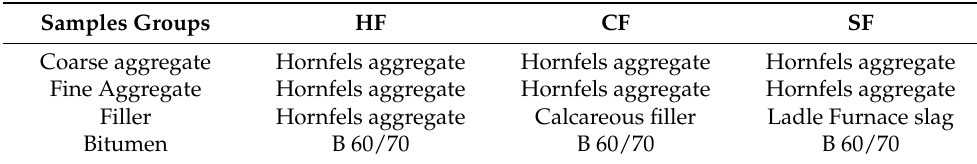
Table 2. Denomination and conforming elements of each family of bituminous mixtures made with different fillers.